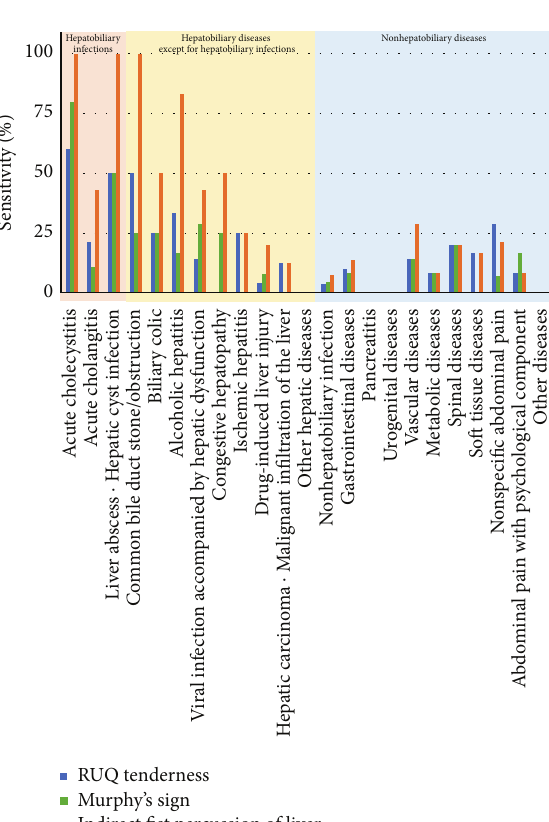
Figure 1: Diagnostic sensitivity. The sensitivity of indirect fist percussion of the liver was higher than that of Murphy’s sign for acute cholecystitis and acute cholangitis. Indirect fist percussion of the liver tended to be positive in the presence of cholelithiasis, alcoholic hepatitis, viral hepatitis, and drug-induced hepatitis. and cholangitis, respectively, being higher than that of Mur- phy’s sign ( 𝑝 = 0.042 , Bonferroni correction) (Figure 1). Indirect fist percussion of the liver tended to exhibit higher sensitivity compared to RUQ tenderness ( 𝑝 = 0.073 , Bonferroni correction) and a significantly higher sensitivity than Murphy’s sign for hepatobiliary infection ( 𝑝 = 0.039